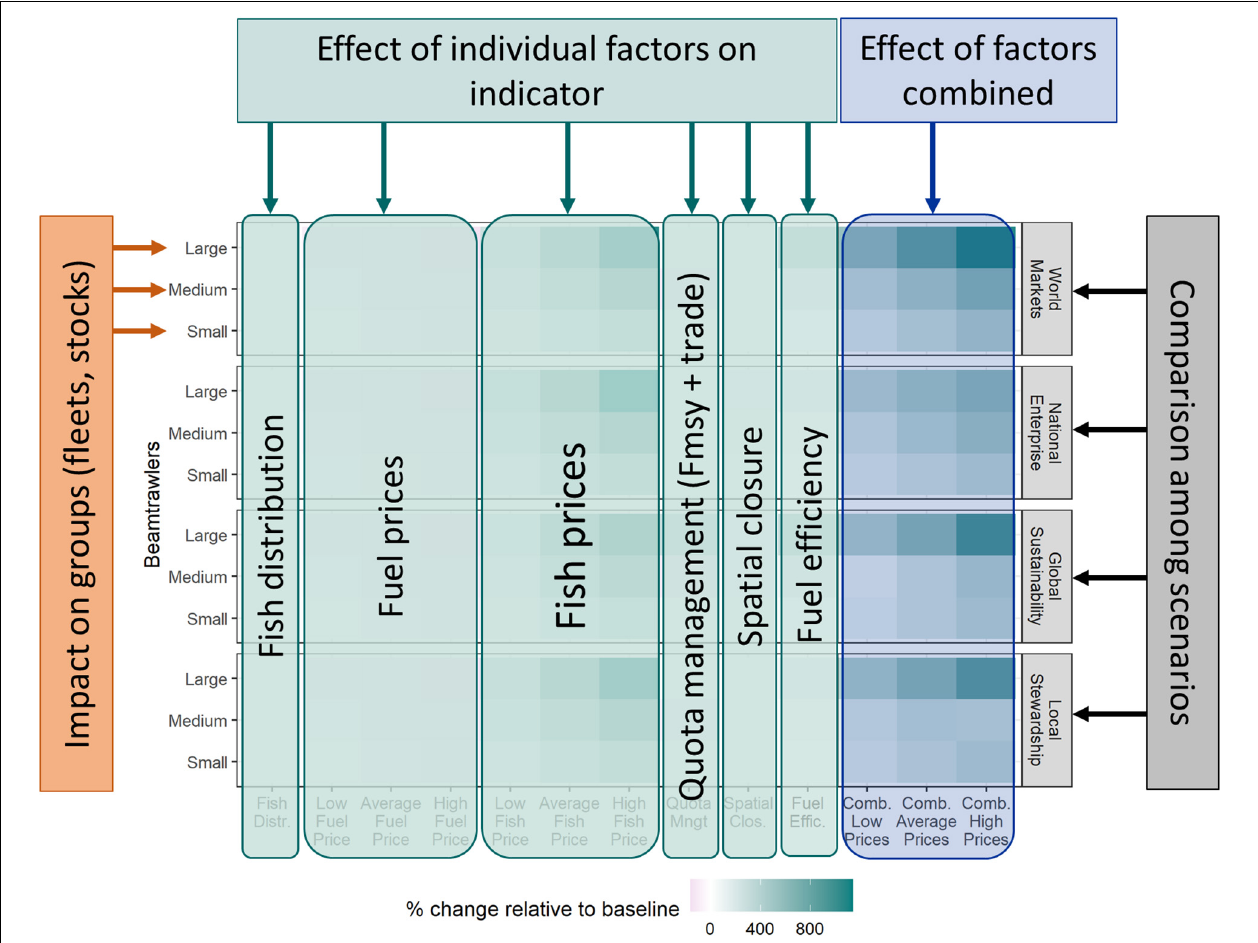
FIGURE 6 | Guidance framework to navigate the model results on a specific indicator. Effects of the individual factors can be seen in the green columns, left of the vertical line, effects of the factors combined in the blue columns, right of the vertical line. The impacts can be viewed per scenario (blocks of rows) for different groups (species or fleets in rows). Factors include Fish Distr.: change in species distribution, fuel/fish price: low, average and high fuel/fish price trends as defined in Table 1 , Exploit. Rate: different FMSY target for sole and plaice; spatial Clos,: marine spatial planning; Fuel Effic.: increase in fuel efficiency; Comb. Low/Average/High Prices: scenarios combining all the factors with low/average/high fish and fuel prices as defined in Table 1